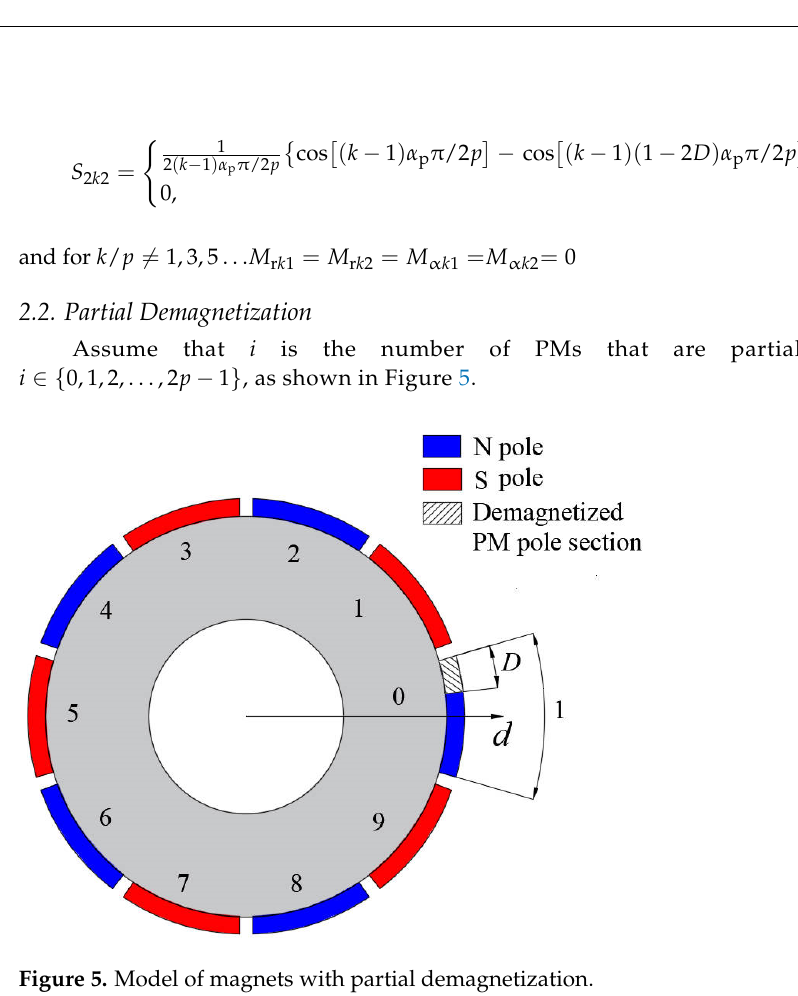
The waveforms of radial and tangential components of the magnetization for healthy PMs and partially demagnetized PMs are shown in Figure 6.